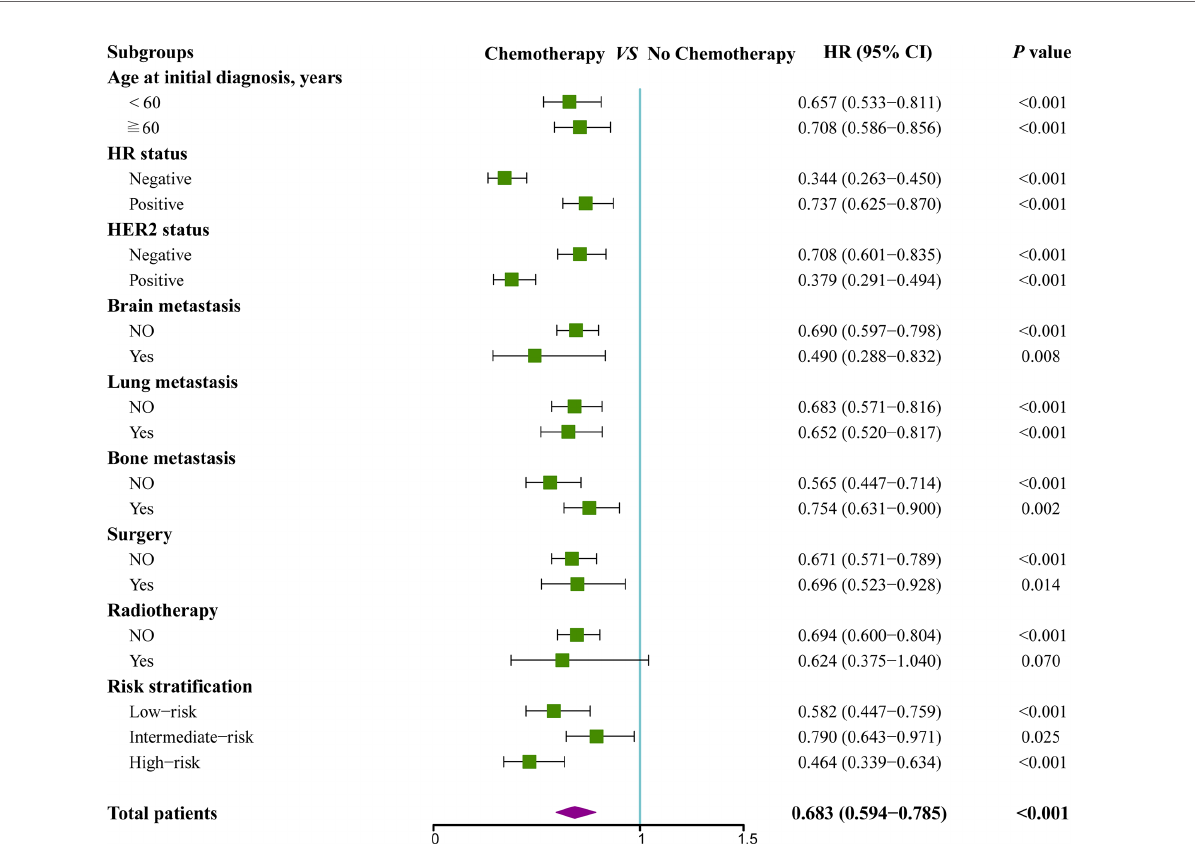
FIGURE 6 | Subgroup analysis of overall survival for patients who received chemotherapy or